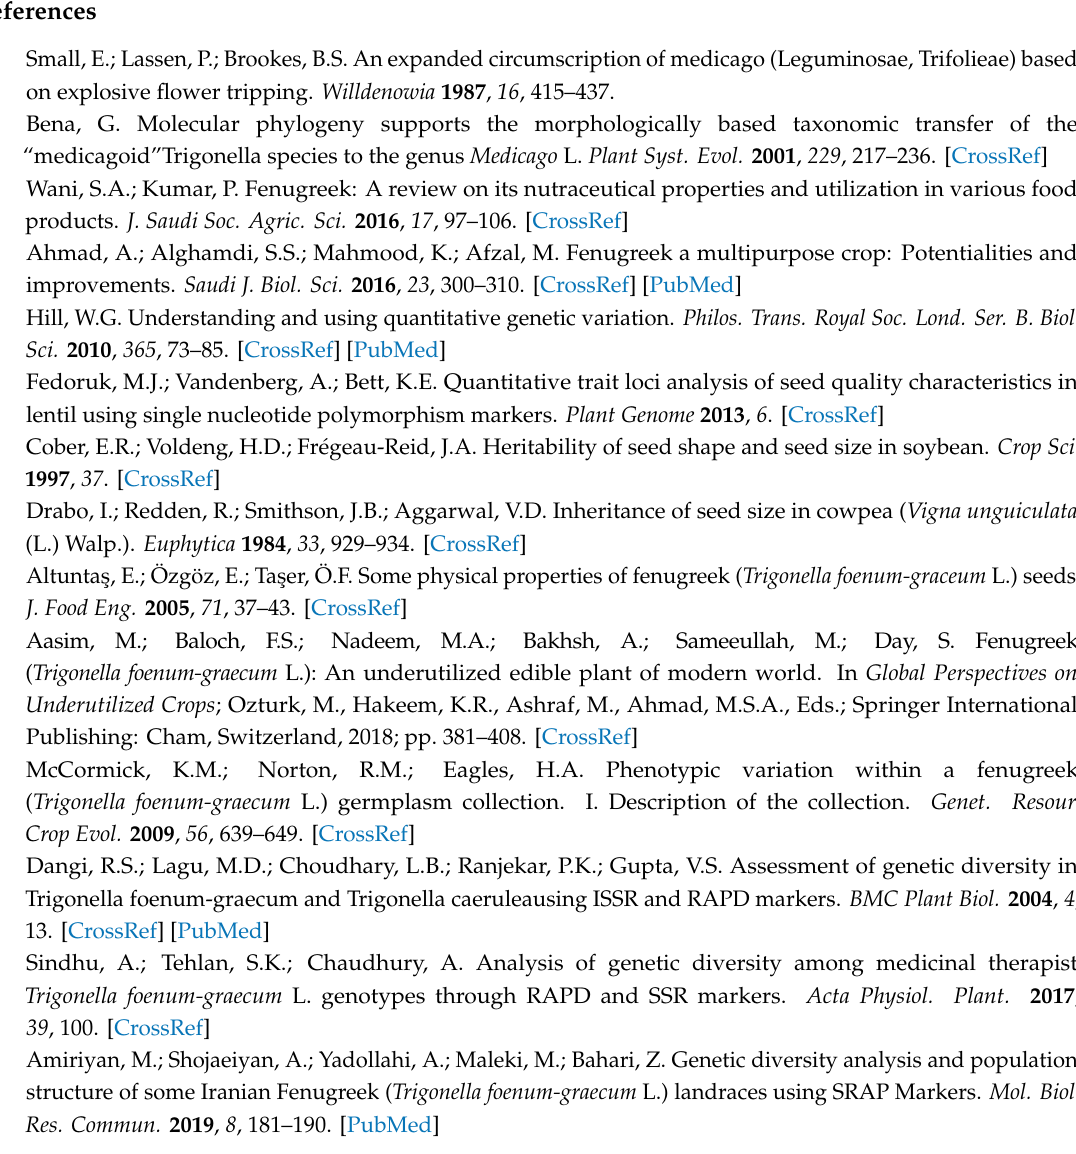
Table S1: Geographic information of the 112 tested fenugreek genotypes; Table S2: Values of seed length, width, and color (RGB) and their corresponding qualitative values used for the association mapping; Table S3: Contig sequences, corresponding Trinity transcripts and translation into